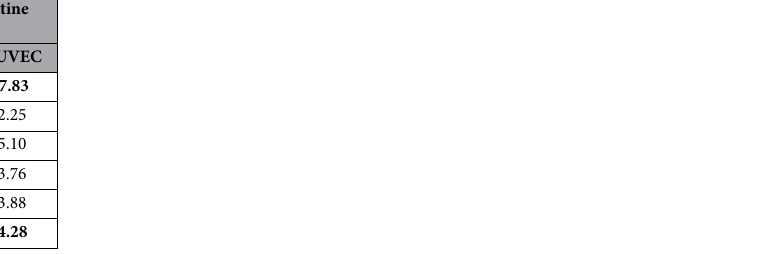
Table 1. The IC 50 values (µM) of CP and gelatine based CP-NPs. Significant values are in